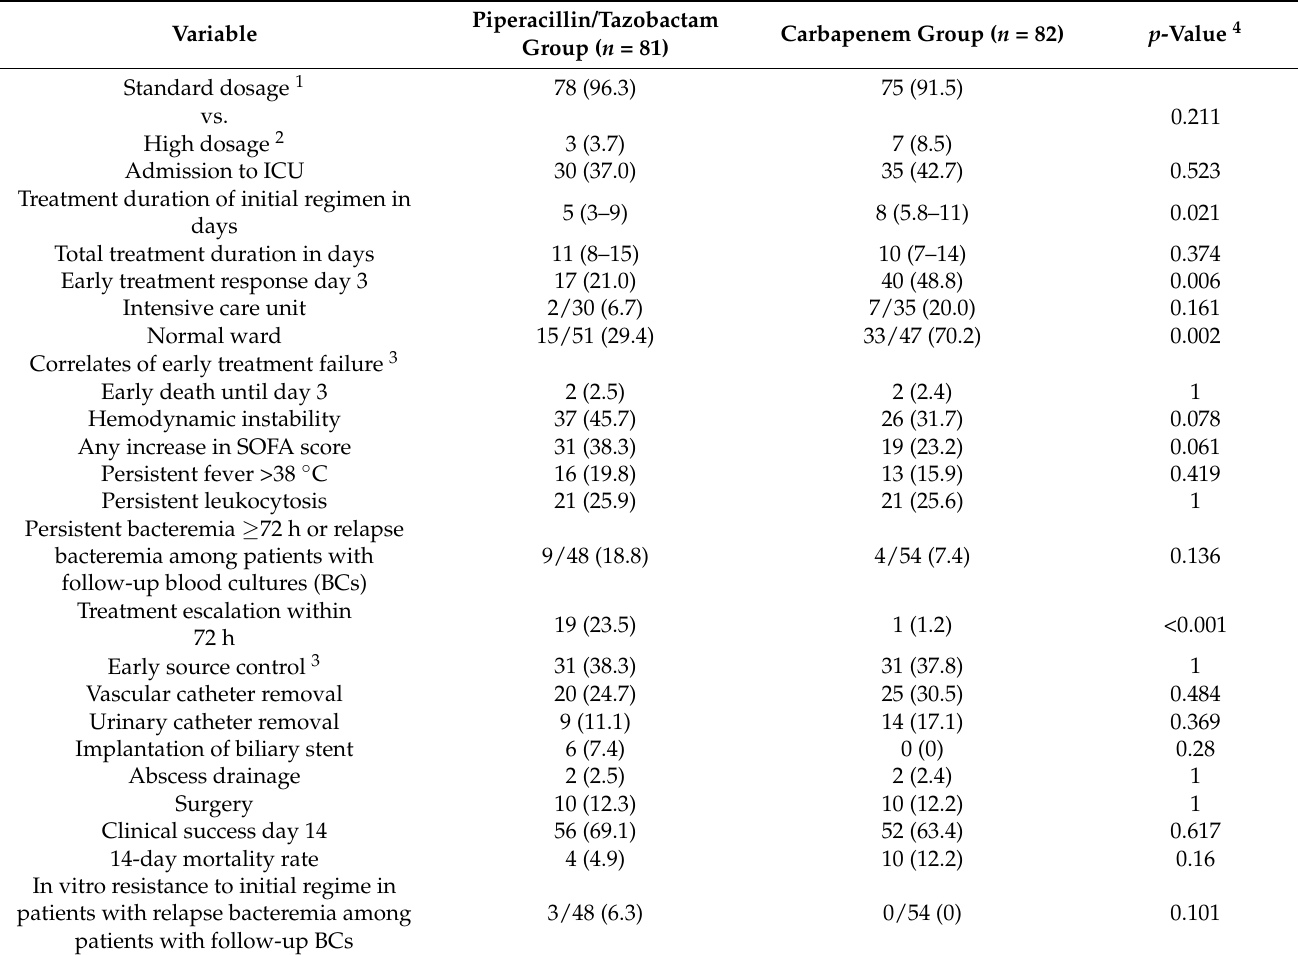
Table 2. Comparison of SPICE bacteremia treatment outcomes between groups of patients treated with the two most common empiric